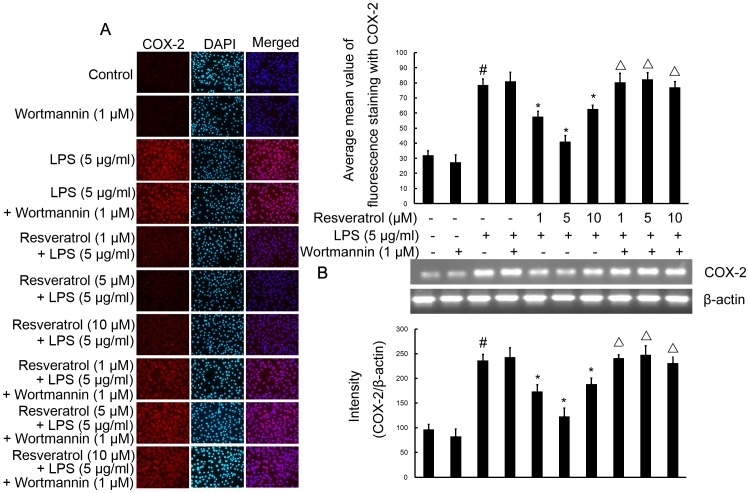
PI3-K is required for resveratrol-inhibited expression of COX-2 protein and mRNA induced by LPS in RAW 264.7 macrophage cells.Panel A shows the immunofluorenscence images for protein expression of COX-2 and Panel B shows the corresponding mRNA data. The relative mRNA level was quantified by scanning densitometry and normalized to β-actin mRNA. Note the up-regulated protein and mRNA expression of COX-2 by LPS is suppressed by different concentrations of resveratrol; however, in cells pretreated with PI3-K inhibitor wortmannin, the suppressive effect of resveratrol is abrogated. The values shown are mean ± SEM of data from three independent experiments. #Significant compared with control alone, p<0.05. *Significant compared with LPS alone, p<0.05. ΔSignificant compared with resveratrol + LPS, p<0.05.